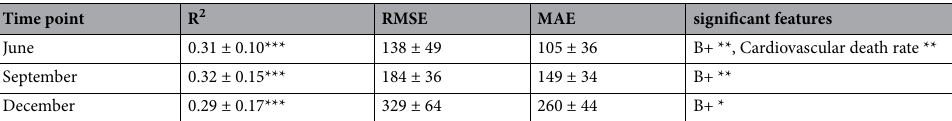
Table 5. Performance metrics of a linear multivariate model applied to the set of features selected by Boruta at each time point, using all countries, averaged over 5 runs of cross validation (with the respective standard deviations). The last column reports only significant features. Significance codes: ‘***’ 0.001, ‘**’ 0.01, and ‘*’ 0.05. The multivariate linear model found feature “B+” to be significant at all three time points, and also found “Cardiovascular death rate” to be significant but only in June. The significance of these features is higher in June and lower but similar in September and December, however most of the linearity is explained by the intercept of the linear